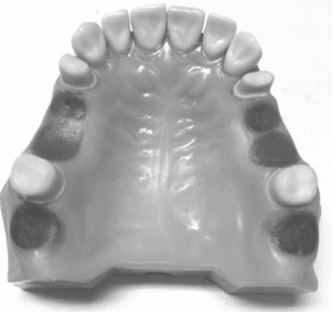
Figure 1. The selected model case for the study.